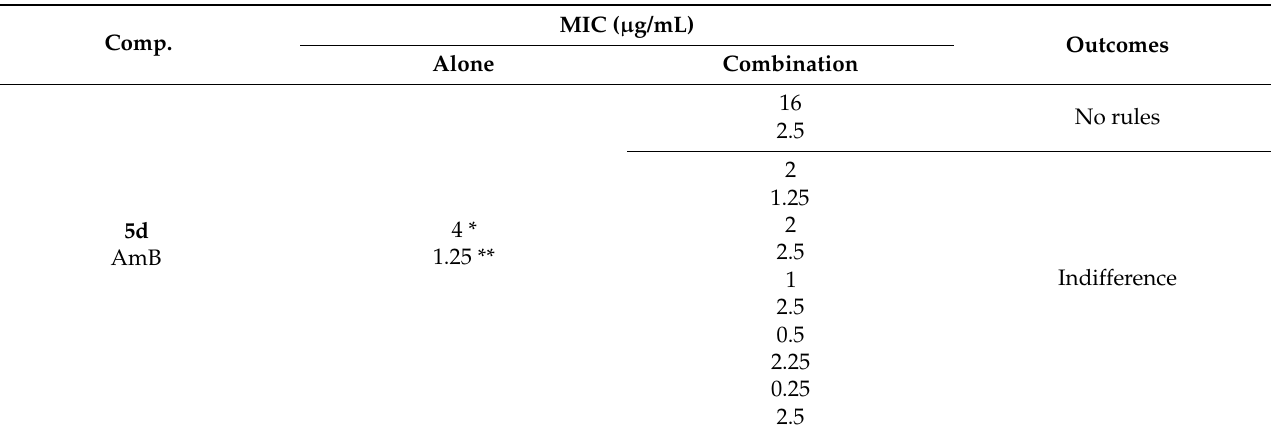
Table 7. FIC indexes of 5d combined with AmB against C. glabrata